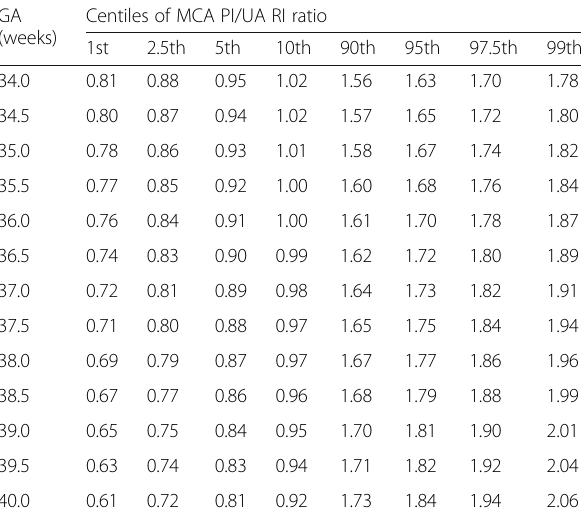
Table 4 Gestational age-defined reference ranges for MCA RI/ UA RI ratio